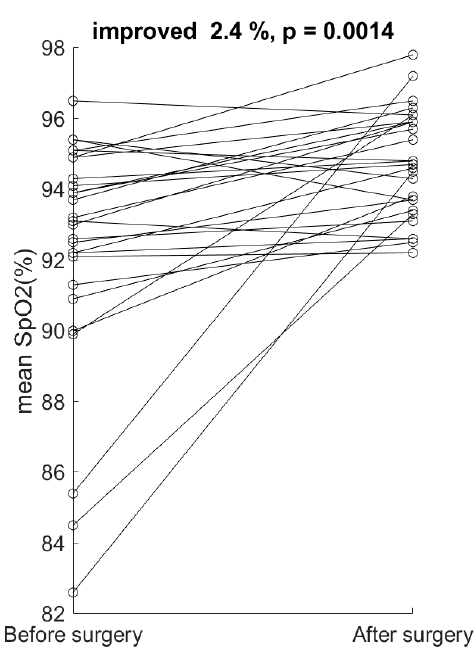
Figure 7. Individual change of mean SpO 2 . After the surgery, the mean O 2 saturation improved 2.4%, p = 0.0014.